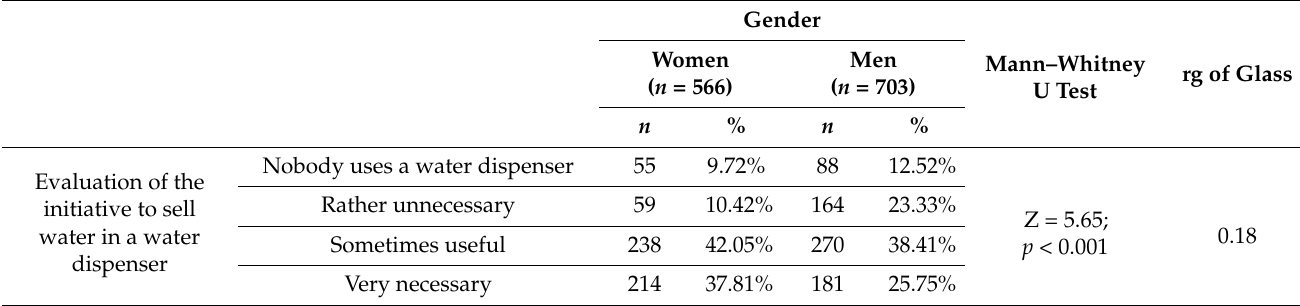
Table 2. The relationship between the gender of the respondents and their assessment of the initiative to sell water in a water dispenser.